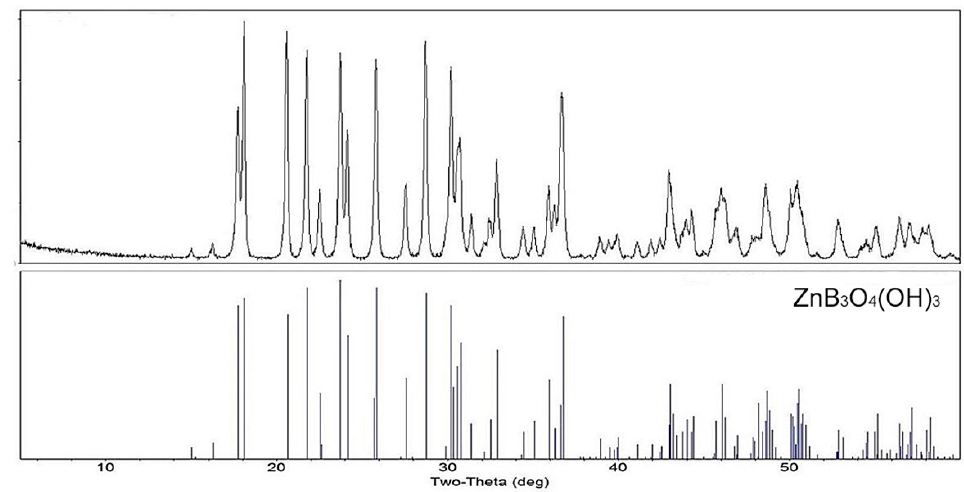
Figure 2 . PXRD pattern of unhydrolyzed zinc borate compared to a reference file for this phase. When the boron and zinc concentrations of the supernatant solution in a 10 wt% aqueous suspension of zinc borate were monitored over time, it was found that approximately one month is required to reach equilibrium, as shown by the graph in Figure 3. As expected, more dilute suspensions achieve equilibrium more rapidly. A 0.05 wt% suspension of ZnB 3 O 4 (OH) 3 completely hydrolyzes within 24 h.